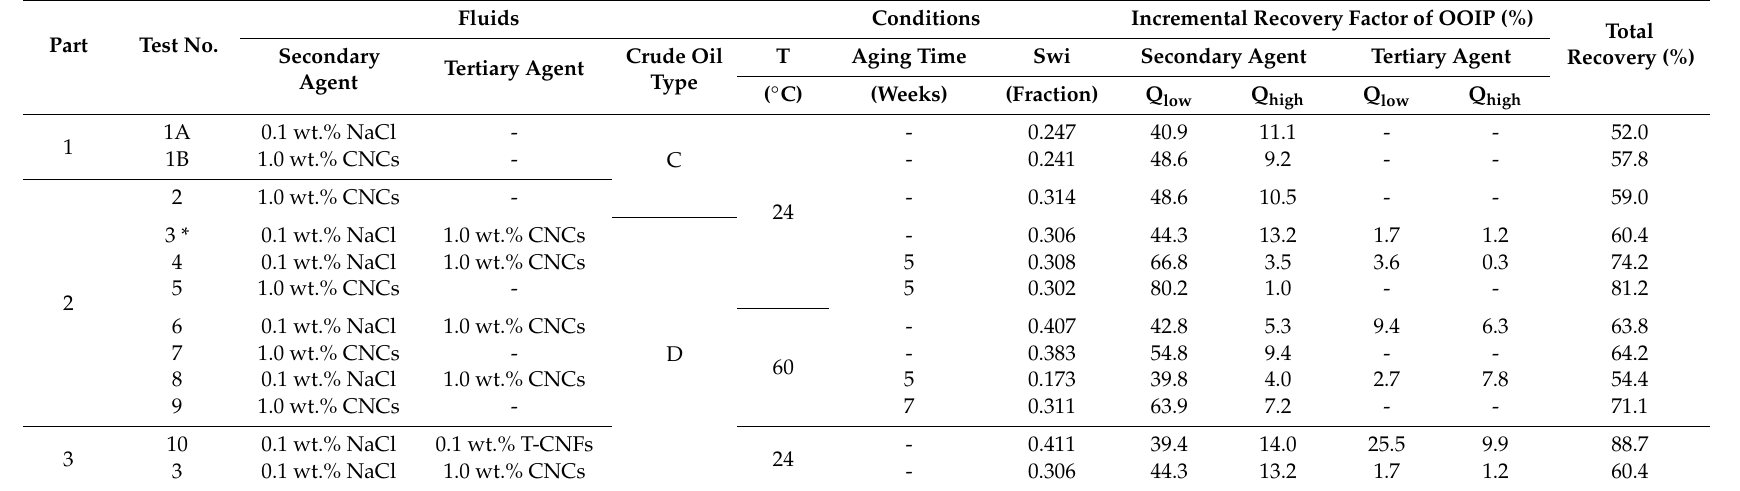
Table 10. Summary of initial water saturations (S wi ) and recovery factors (as% OOIP) for the core floods for each of the flooding stages (low rate (Q low ), 0.3 mL / min and high rate (Q high ), 3.0 mL / min). * This test has been used for comparison with an experiment in Part 3. Part Test